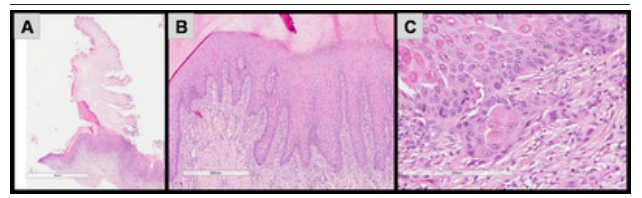
FIGURE 2 – Histopathological image shows: A) conical hyperkeratosis and parakeratosis consistent with CH; B) at the base of the lesion, the stratified squamous epithelium exhibited hyperkeratosis, spongiosis, acanthosis; C) epithelial area depicting mild-to-moderate epithelial dysplasia CH: cutaneous horn.